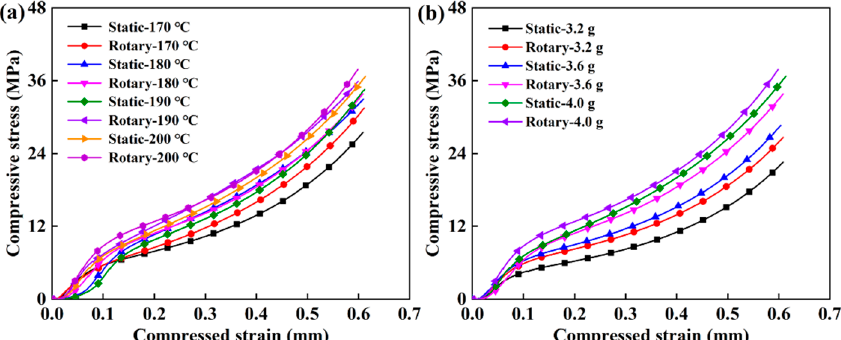
Figure 6. The compressive strength of the sample under different process conditions: ( a ) Trends of compression properties of samples obtained by different molding methods with respect to the change in temperature when the charging amount was 4 g, and ( b ) trends of compression properties of samples obtained by different molding methods with respect to the change in charging amount when the sintering temperate was 200 ◦ C.